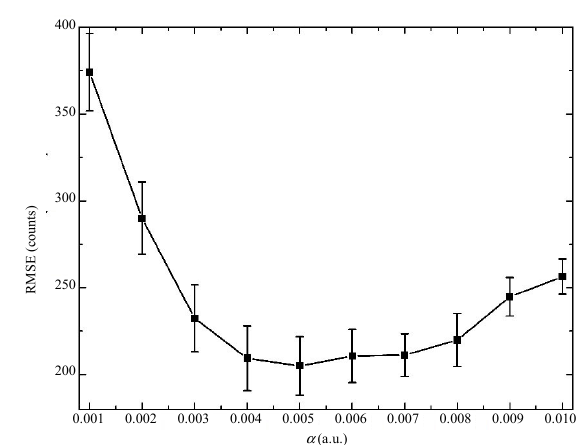
Fig. 4 Relationship between the parameter α and RMSE.